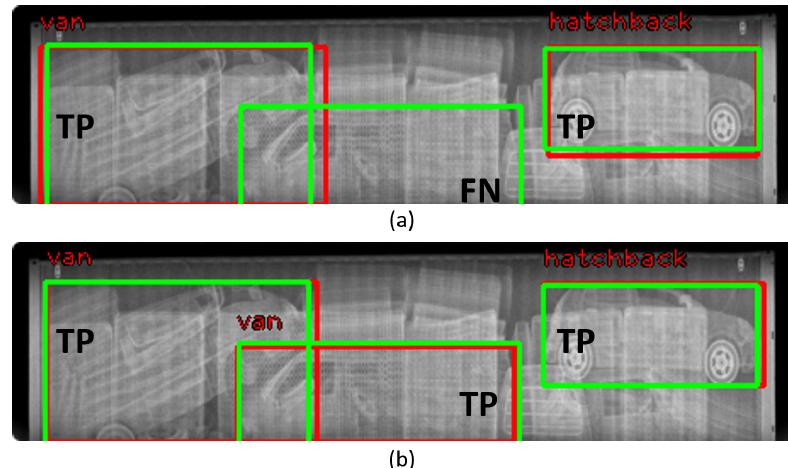
Figure 15. Comparison of detection results: ( a ) result of training with real BSX data; ( b ) result of training with Real+Fake (LTH). Green: ground truth; Red: prediction. TP: true positive; FN: false